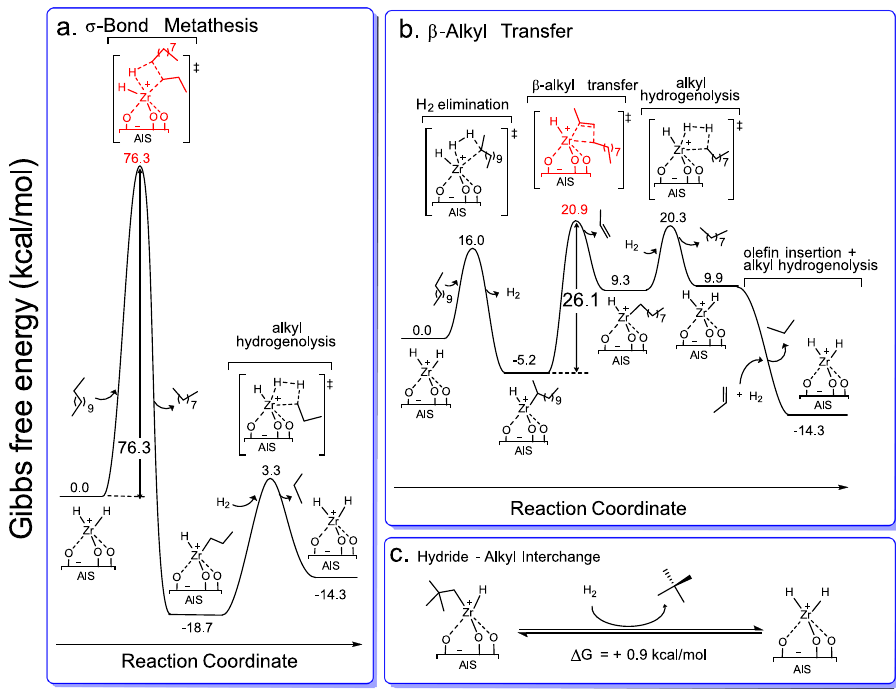
Fig. 6 | Computed reaction coordinates for AlS/ZrH 2 -catalyzed n -dodecane hydrogenolysis via plausible turnover-limiting pathways. a C – C scission via